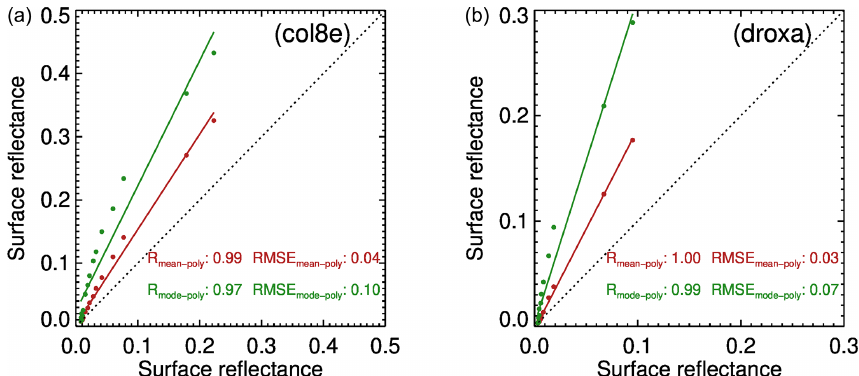
Figure 16. The comparison between simulated snow reflectance using a mono- and polydisperse snow model consisting of aggregate of columns (a) and droxtal (b) . In the case of the monodisperse model, the SGS is assumed to be the mean and mode value of PSD at the top of the snow layer (see Fig. 14a). The reference value is shown on the x